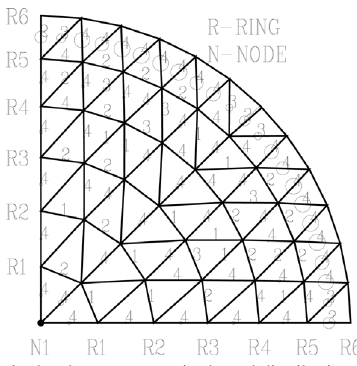
Fig. 6. Plastic development magnitude and distribution. Fig. 7. Vertical displacement-time curve of N1 for different TNT